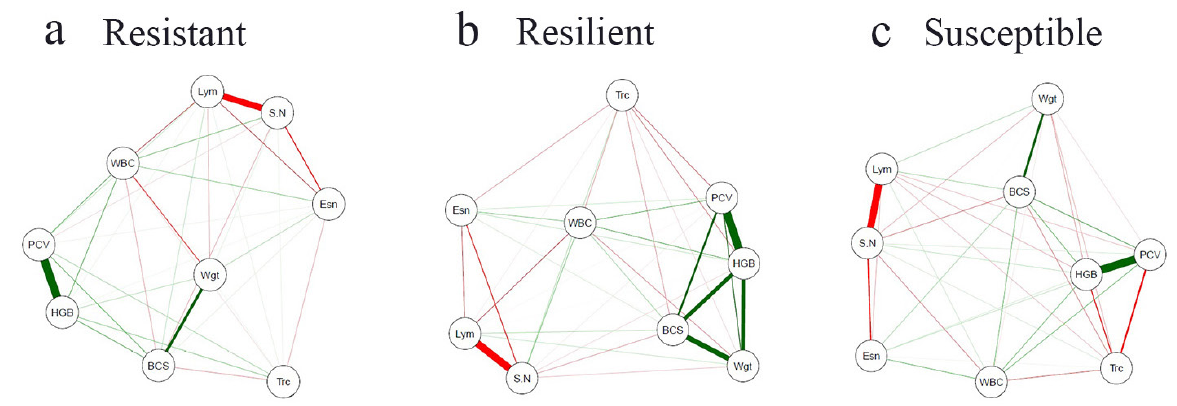
Figure 4 . Correlation network of resistant (a), resilient (b) and susceptible (c) categories: weight (Wgt), body condition score (BCS), packed cell volume (PCV), hemoglobin (HGB), white blood cells (WBC), segmented neutrophils (SN), lymphocytes (Lym), eosinophils (Esn) and Trichostrongylidae eggs (Trc) of Morada Nova ewes in São Paulo state,